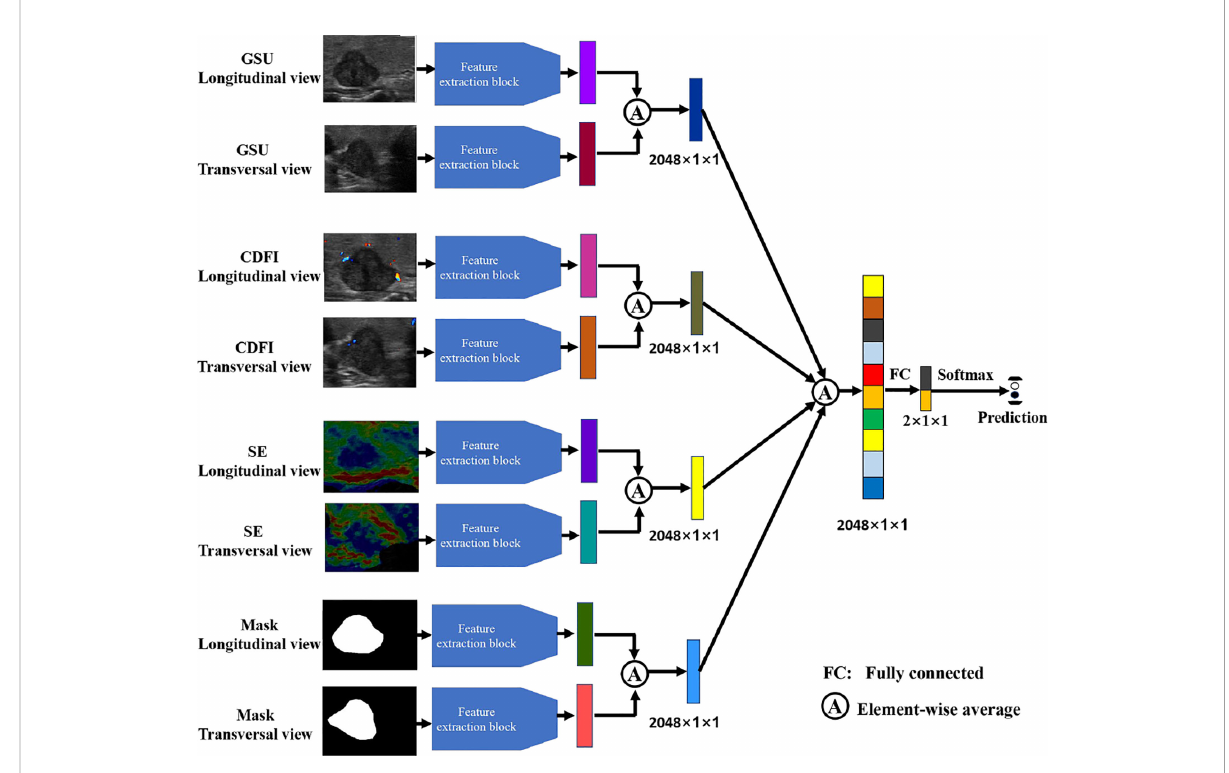
FIGURE 4 The illustration of multimodality inputs and feature